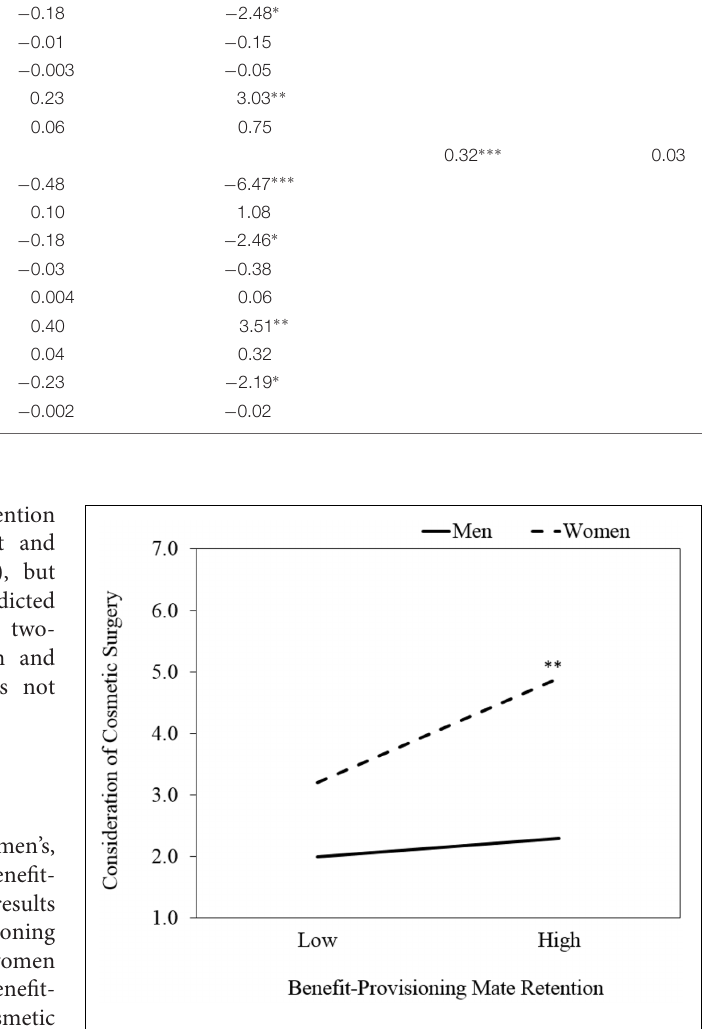
FIGURE 1 | Simple slopes plots for the two-way interaction between Benefit-Provisioning mate retention and sex, predicting consideration of cosmetic surgery. ∗∗ p <